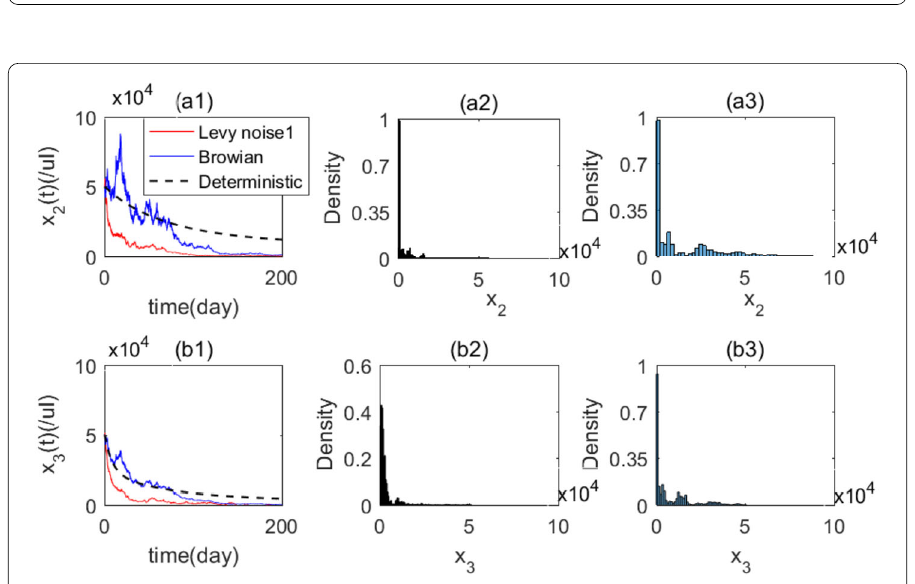
Euler scheme approximation with initial 2